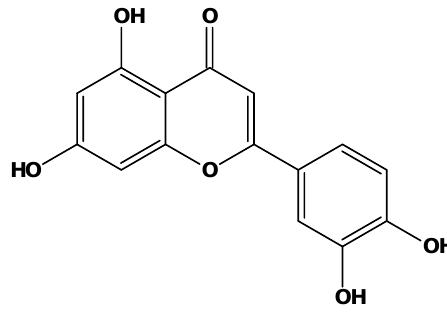
Figure 1. Chemical structure of luteolin.